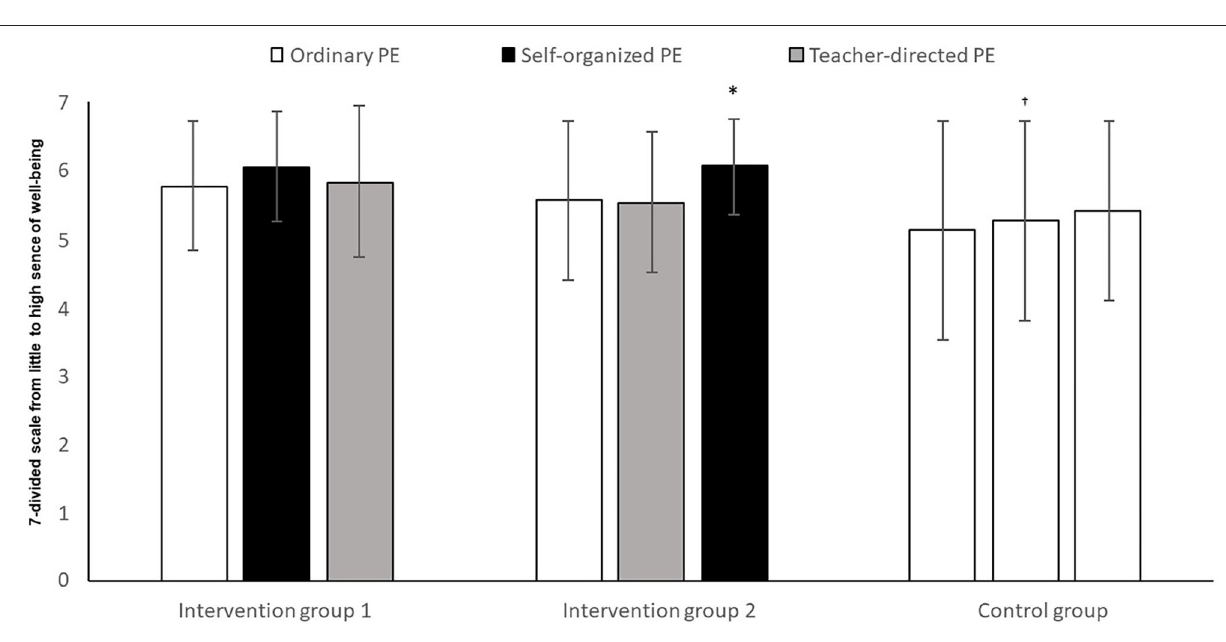
FIGURE 5 | Experience of well-being among pupils after three time periods of ordinary PE, teacher-directed PE, or self-determined PE. *Significantly higher perception of well-being in self-determined PE, compared to ordinary instruction or teacher-directed ( p < 0.05). † Significantly lower perception of well-being in the control group, compared to intervention groups 1 and 2 ( p <